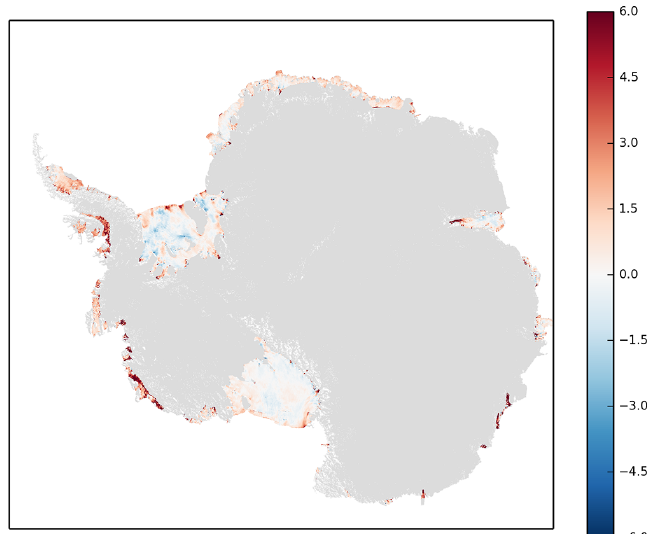
Figure A1. Observations of ice shelf basal melt rate (myr − 1 ) around Antarctica (Adusumilli et al., 2020).